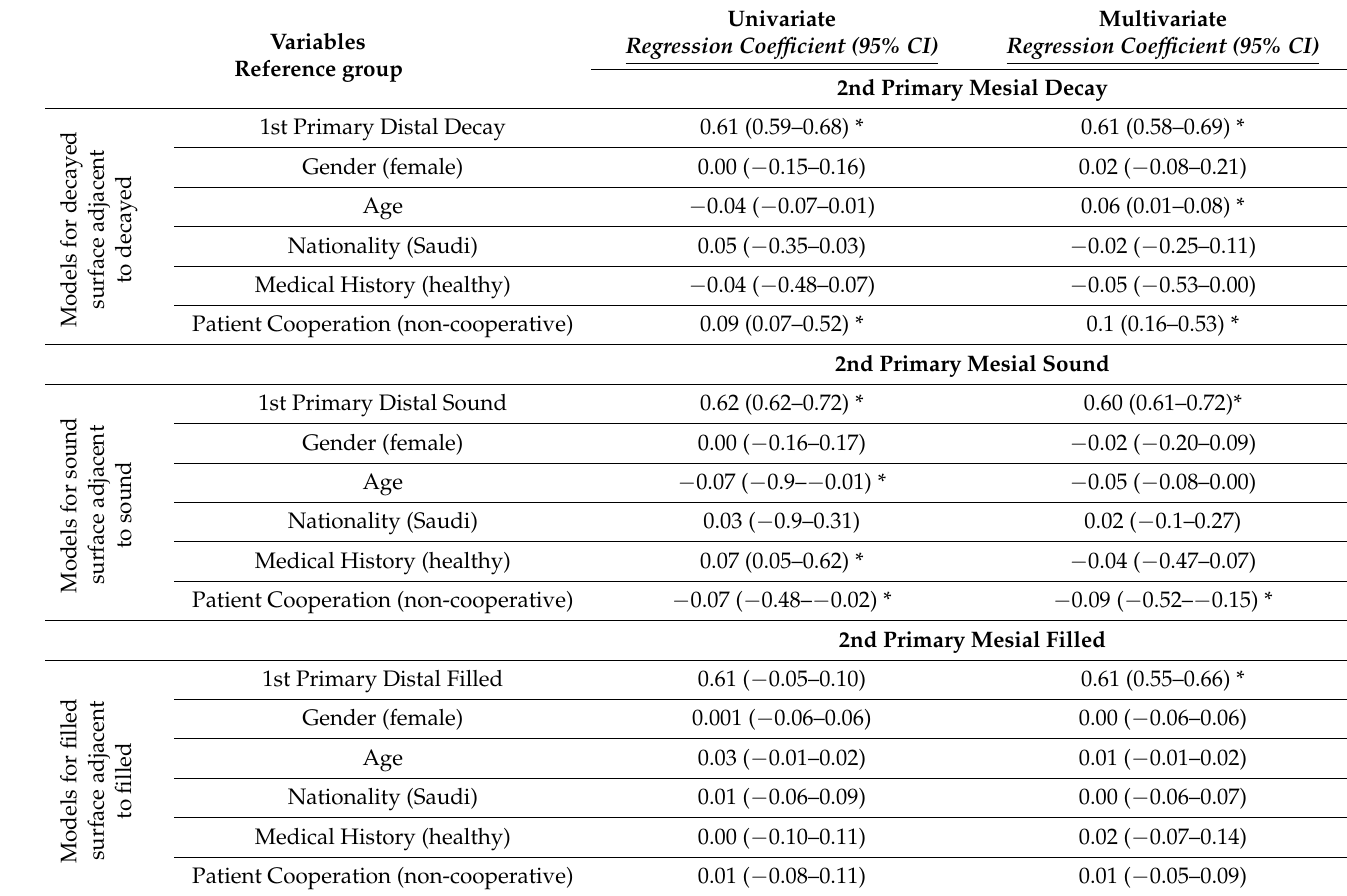
Table 3. Linear regression models showing the influence of patients’ behaviors on the associations between the sound, carious, and filled 1st and 2nd primary molars, adjusted for demographical variables ( n =